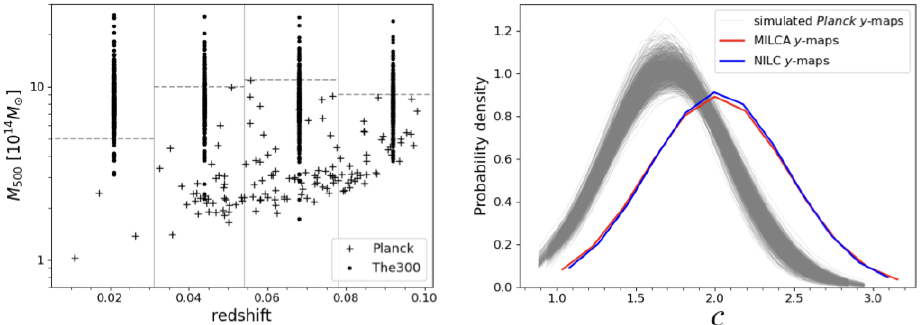
Figure 2. Left: mass-redshift distribution of 135 Planck -SZ clusters and of the synthetic clusters gen- erated in The300 project at four redshifts. The vertical thin lines mark the redshift bins we used to compare the Zernike analysis on Planck and mock ( Planck -like) y -maps. The horizontal dashed lines indicate the upper-mass limits defined to randomly extract the synthetic clusters in each bin. Right: probability density for the distributions of computed on mock y -maps of the synthetic clusters (grey) C and on MILCA (red) and NILC (blue) y -maps of the Planck